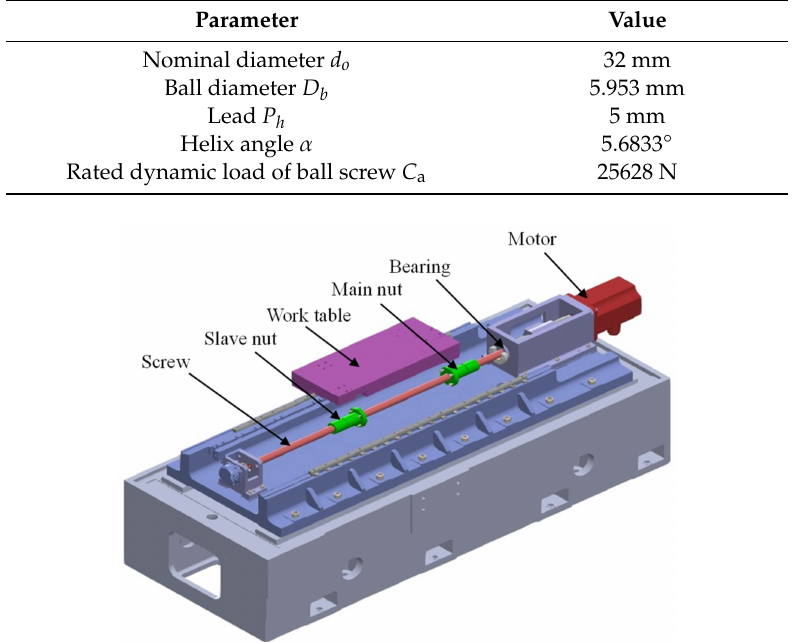
Figure 3. Test table for the ball screw.